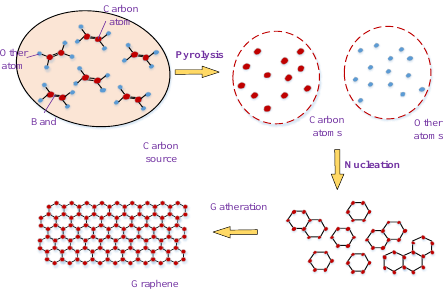
Figure 2. Mechanism of thermal method for growing of graphene.